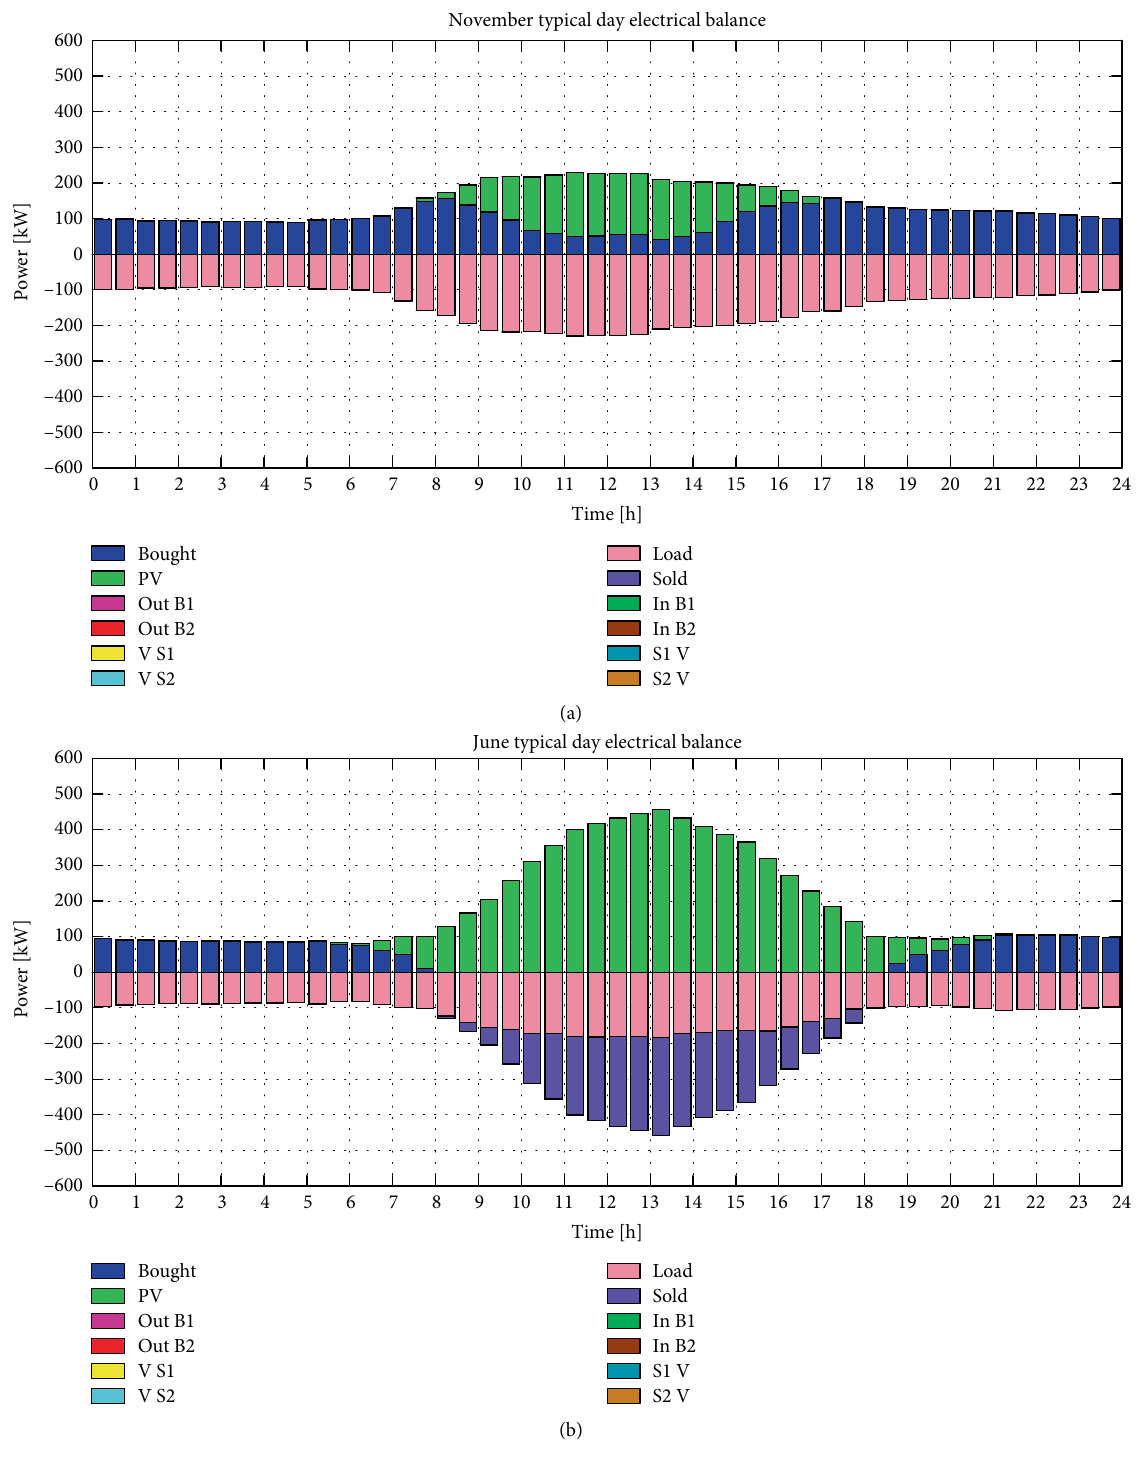
Figure 1: (a) November day electrical balance for Case 2, (b) June day electrical balance for Case